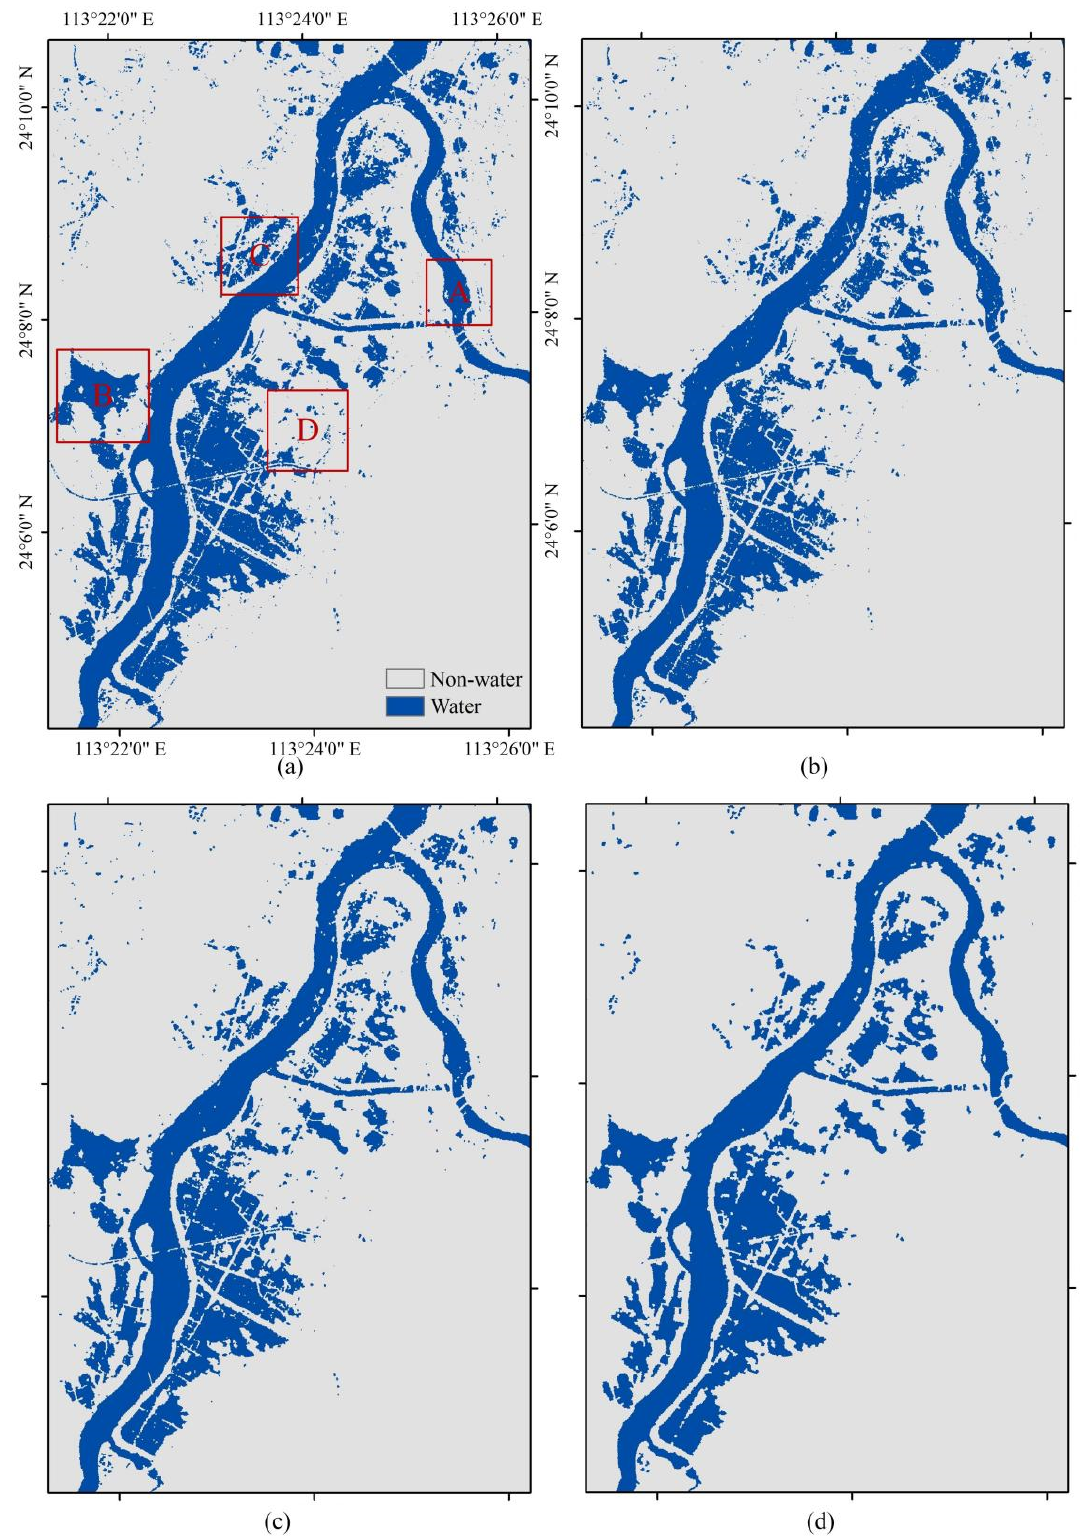
Figure 6. Water delineated by using ( a ) Otsu’s method, ( b ) KI’s method, ( c ) the KI-MRF algorithm, and ( d ) the KI-MRF-SA algorithm in Boluokeng. The red boxes mark some remarkably changed spots (A, B, C and D) and method enhancements.